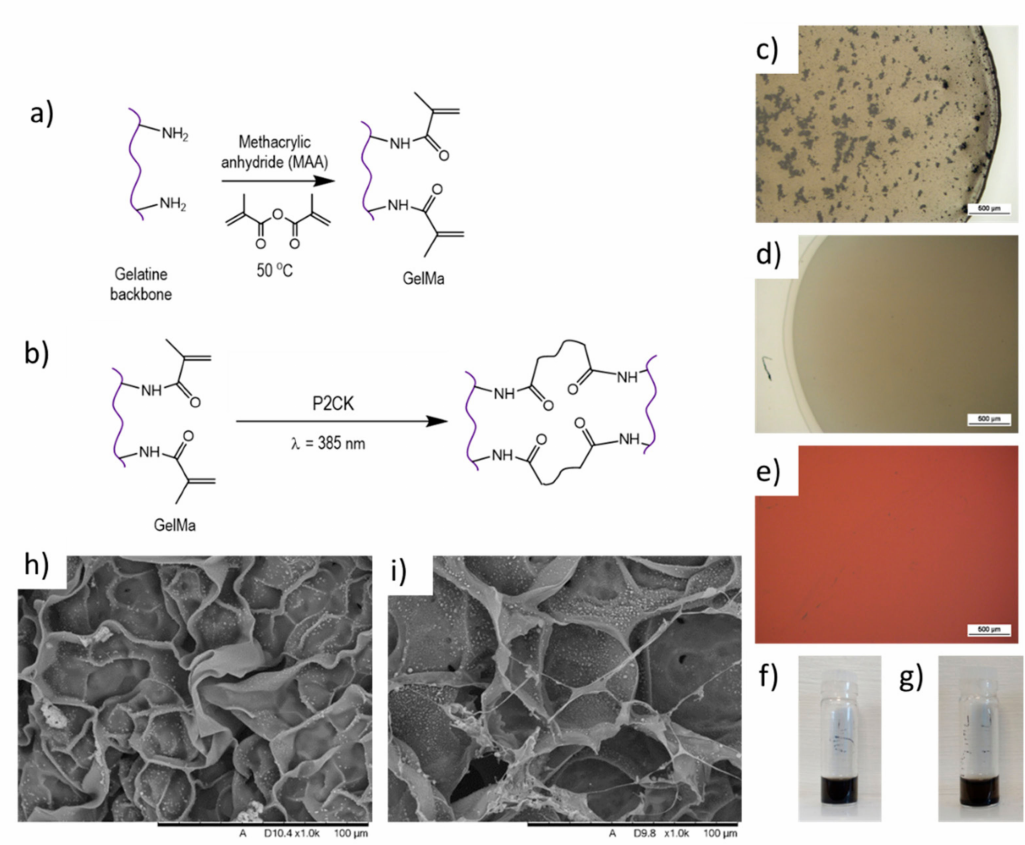
Figure 1. Mechanisms of ( a ) modification of gelatine with methacrylate groups to obtain gelatine methacrylate (GelMa) and ( b ) photo-polymerisation of GelMa groups to obtain a cross-linked gel. GelMa pre-polymer hydrogel (5 wt. %) with 1 mg mL − 1 multi-walled carbon nanotubes (MWCNTs-GelMa) ( c ) before and ( d ) after centrifugation and ( e ) ink formulation after addition of photoinitiator. Stability of MWCNTs-GelMa solutions ( f ) 3 and ( g ) 45 h after MWCNTs dispersion. SEM imaging of lyophilised ( h ) GelMa and ( i ) MWCNTs-GelMa